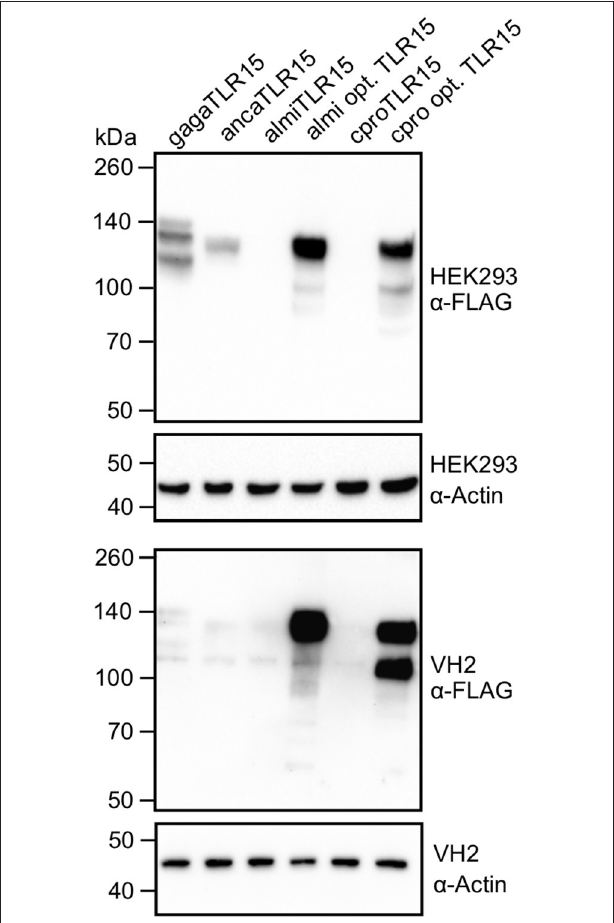
FIGURE 7 | Expression of codon optimized alligator and crocodile TLR15. Immunoblot analyses of HEK293 cells and VH-2 cells expressing C-terminal FLAG-tagged chicken (gaga), anolis (anca), alligator (almi), codon optimized alligator (almi opt.), crocodile (cpro), or codon optimized crocodile (crpo opt.) TLR15. Mature TLR15 is ∼ 140 kDa. Beta-actin was detected to confirm equal loading of HEK293 and VH-2 total protein onto SDS-PAGE gel. Results are representative of at least two independent